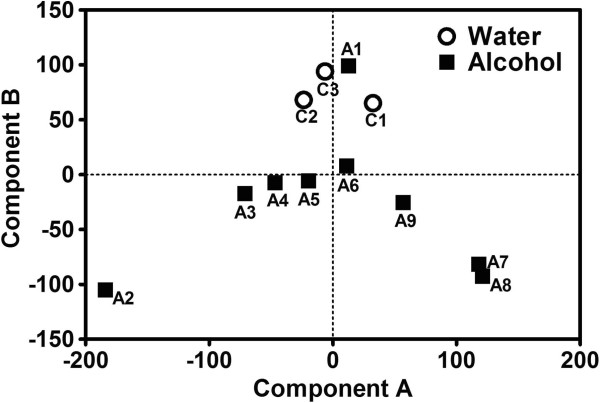
Principal component analysis (PCA) plot of microarray gene expression study. Twelve samples were used: C1 – C3 for water control mice (open circles), and A1 – A9 for alcohol consumption mice (filled squares). All probe sets that passed the filters for high-quality array data (see Methods) were used for the analysis. Component A is plotted on the horizontal axis and component B is plotted on the vertical axis.